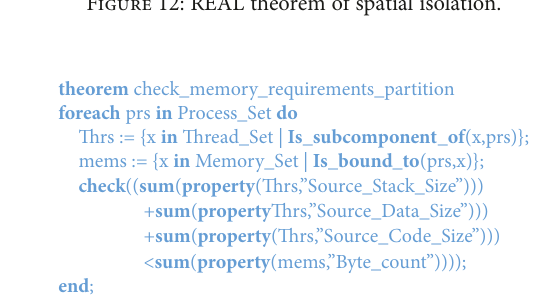
Figure 12: REAL theorem of spatial isolation.